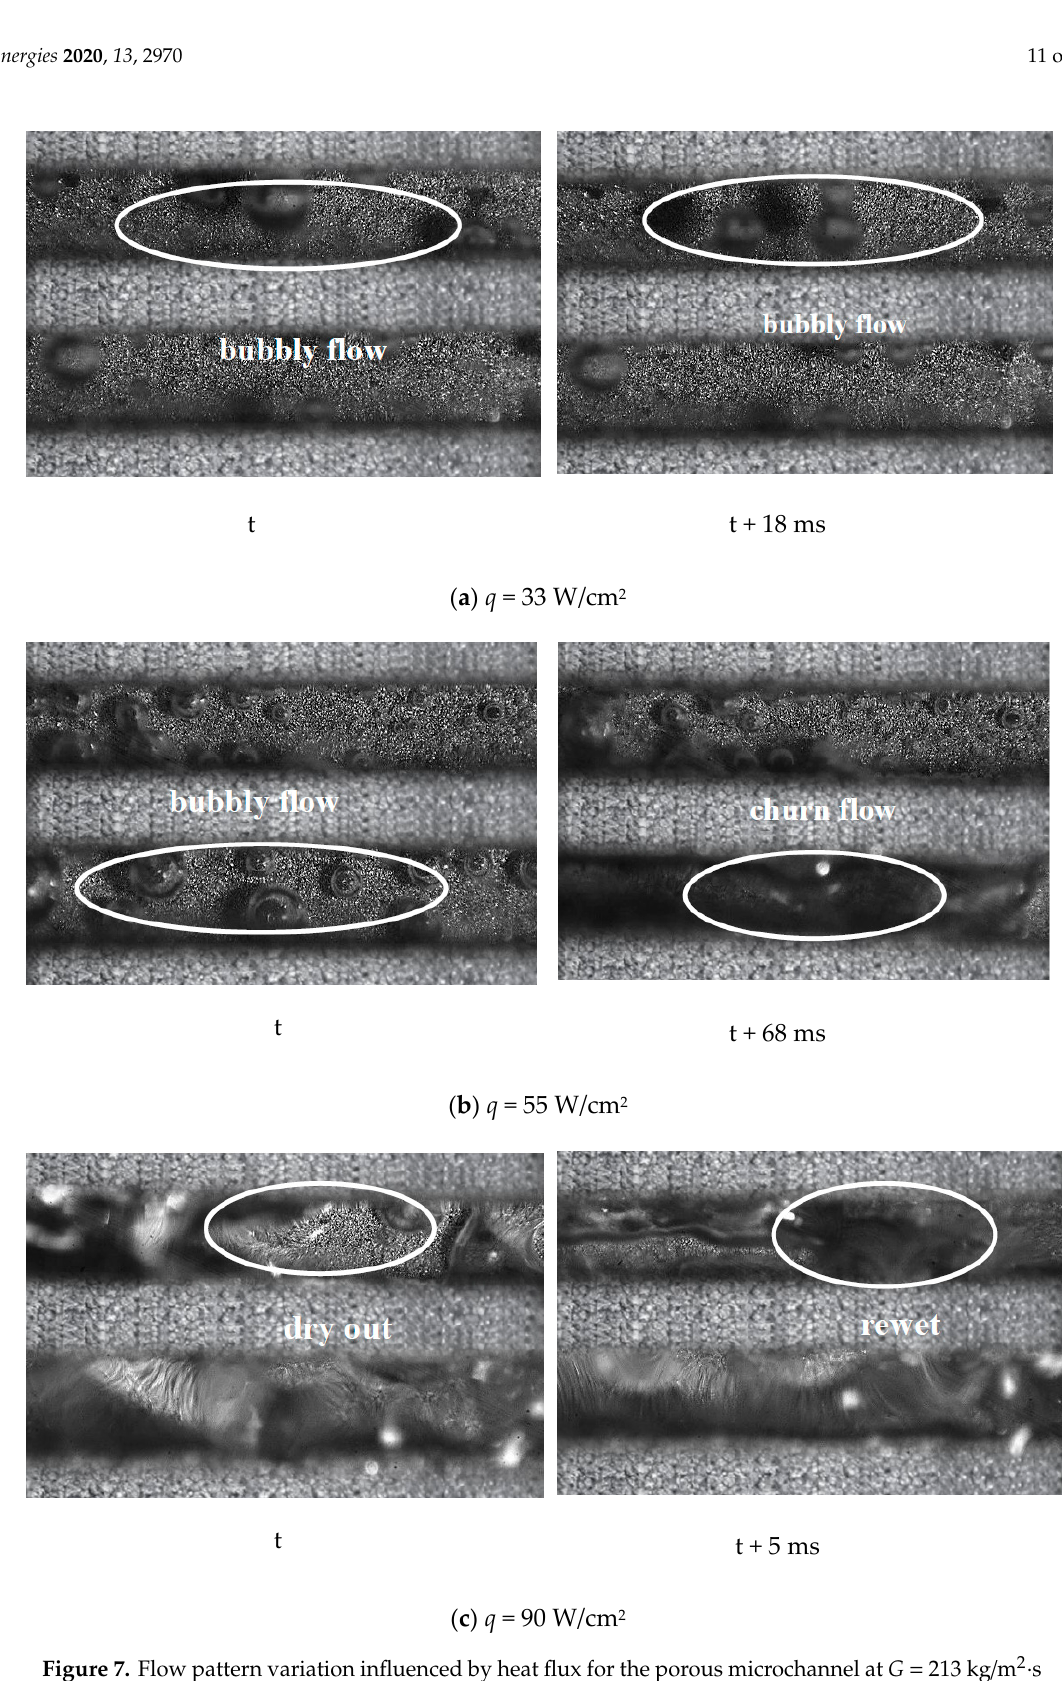
Figure 7. Flow pattern variation influenced by heat flux for the porous microchannel at G = 213 kg/m 2 ·s and T in = 60 °C.